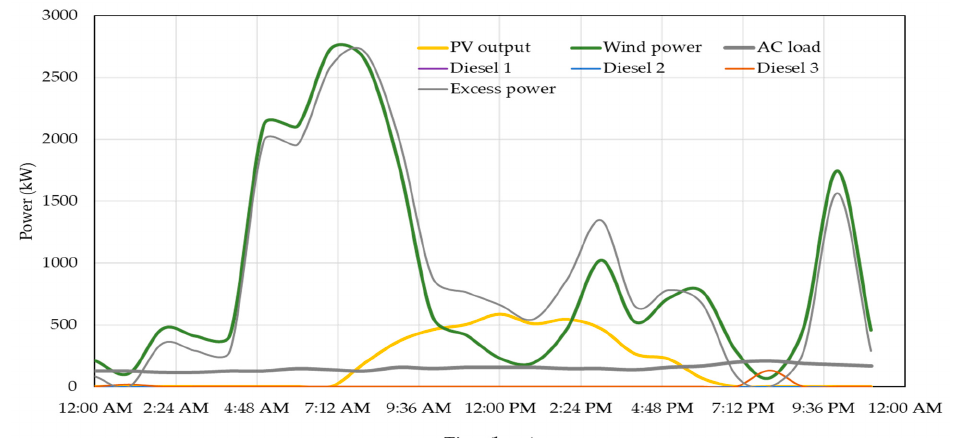
Figure 12. Power balance between the generations and load on a day with minimum load (during